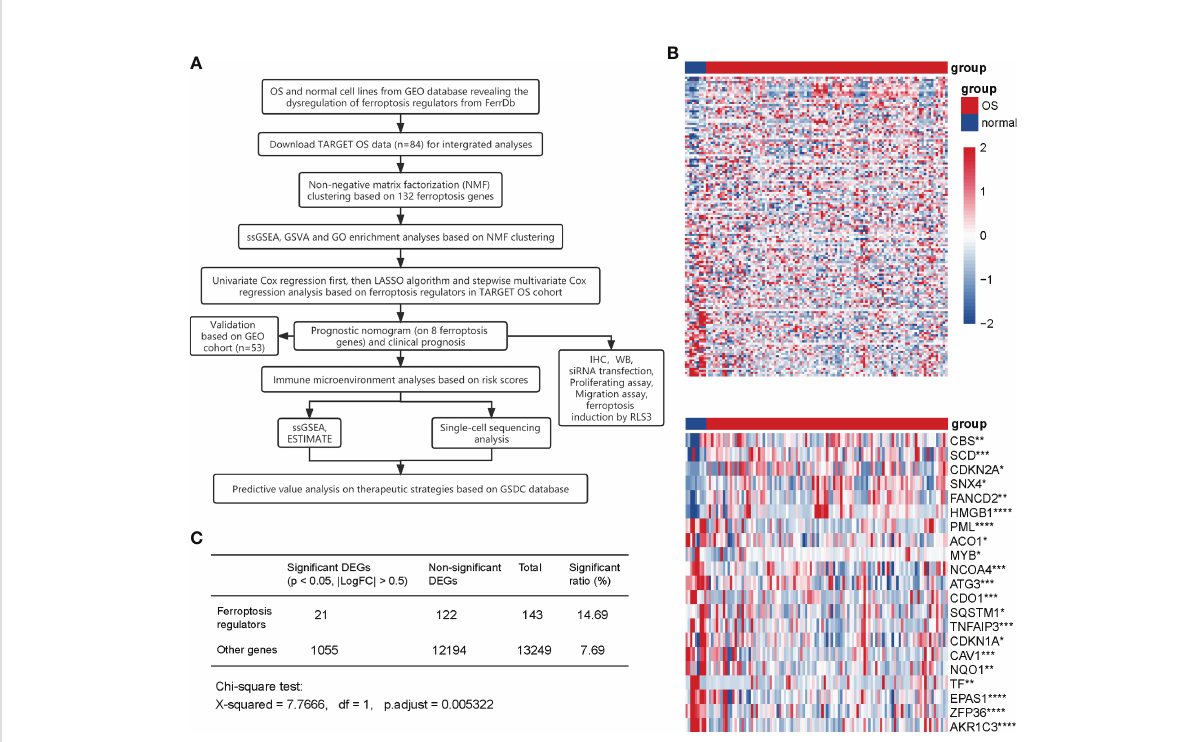
FIGURE 1 Expression of ferroptosis regulators in normal and OS cell lines. (A) Flow diagram of the study. (B) Heatmaps of the expression of 143 detected ferroptosis regulators (up) and 21 signi fi cant DEGs (|LogFC| > 0.5, P < 0.05) (down). Red represents high expression level and blue represents low expression. The darker the color, the greater the signi fi cance. (C) Chi-square test for the signi fi cance of ferroptosis DEGs. * P < 0.05; ** P < 0.01; *** P < 0.001; **** P <